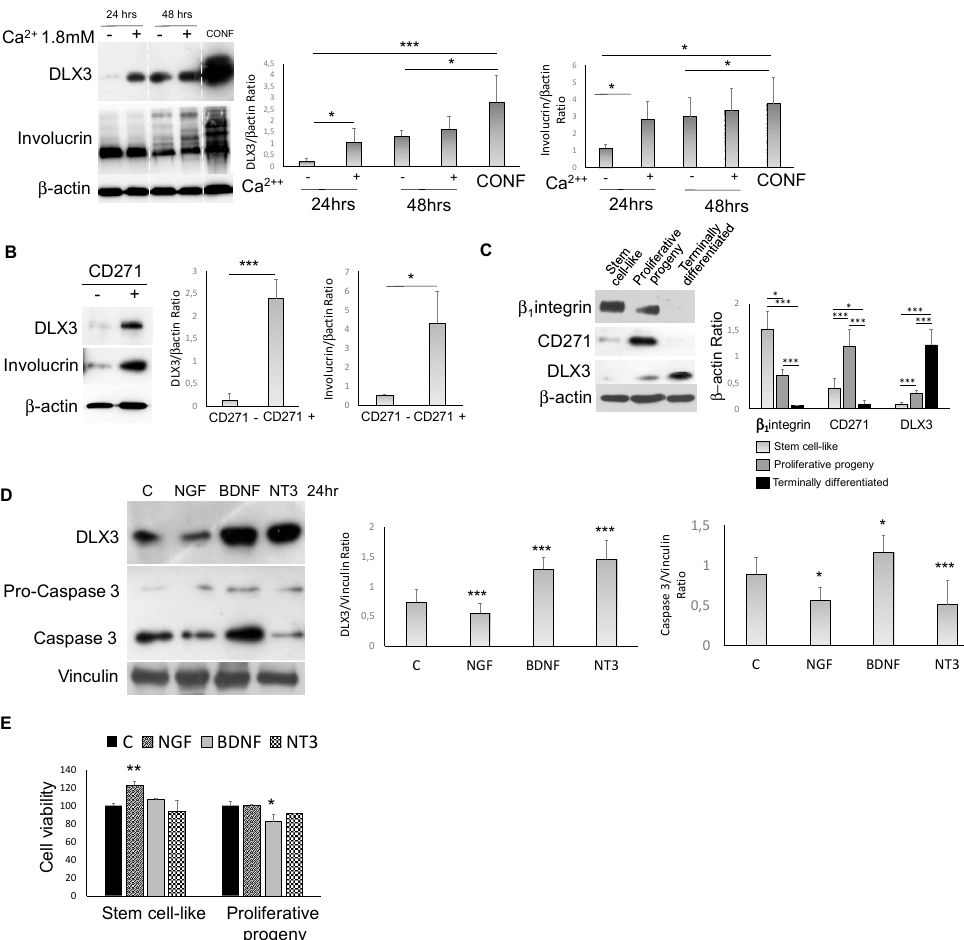
Figure 3. CD271-DLX3 interplay in keratinocytes ( A ) DLX3 and involucrin expression evaluated in human keratinocytes after 24 or 48 h of 1.8 mM calcium treatment or at confluence (CONF) or ( B ) in CD271 negative (CD271 -) and positive (CD271 + ) cells. ( C ) β 1-integrin, CD271, and DLX3 expression